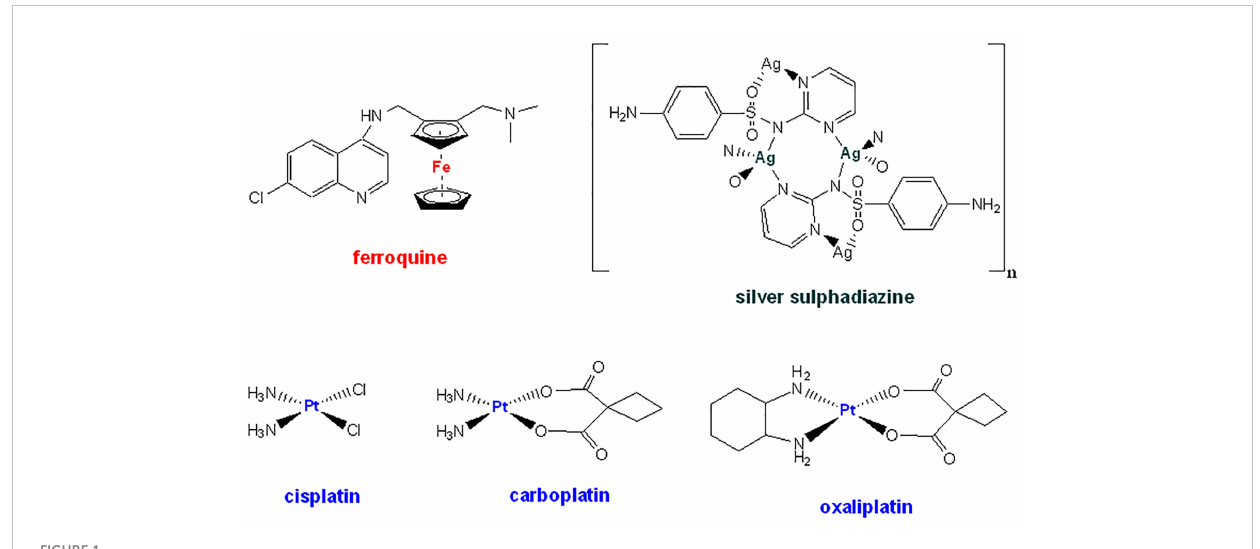
FIGURE 1 Chemical structures for the most relevant metallodrugs with antimicrobial